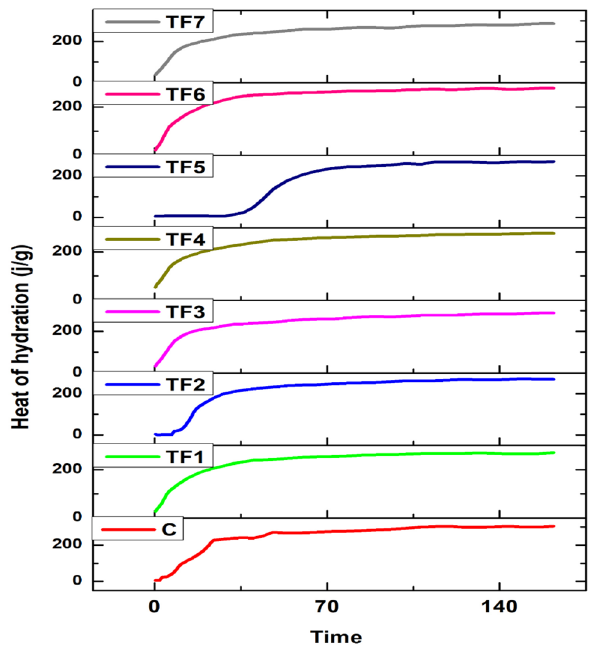
Figure 7. The graphic pattern of the effect of various tuffs on heat of hydration of mortar samples.